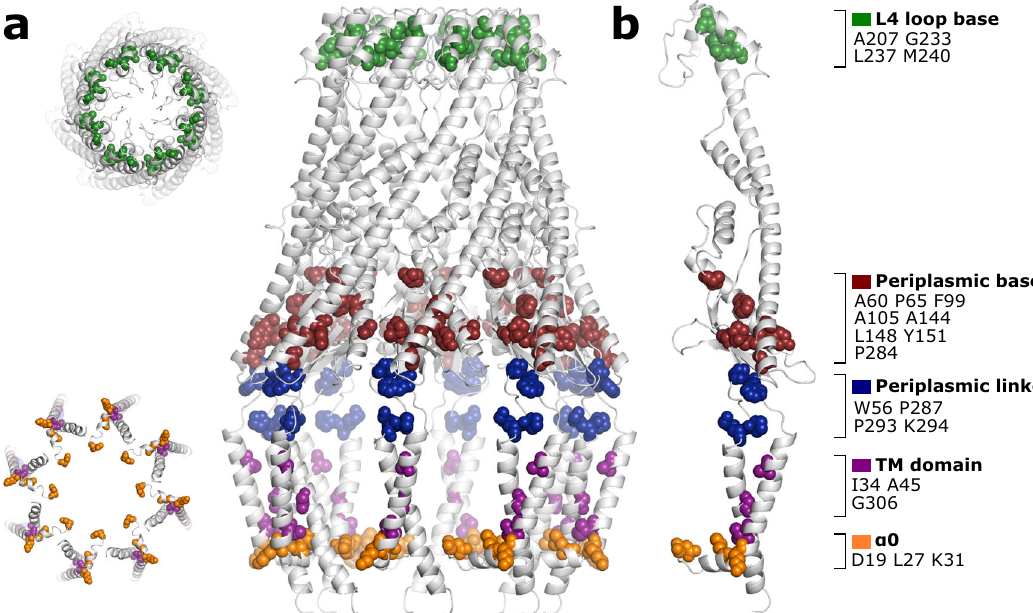
Fig. 6 Location of conserved residues mapped to WzzB. The conserved residues (spheres) can be grouped into fi ve distinct regions: The L4 loop base (green), periplasmic base (maroon), periplasmic linker (blue), TM domain (magenta), and α 0 (orange). a The octameric WzzB complex. Top left: view looking down from the top of the periplasmic domain. Bottom left: view looking up from the cytoplasm. b A single protomer of WzzB. Conserved residues were determined using the ConSurf method 27,28